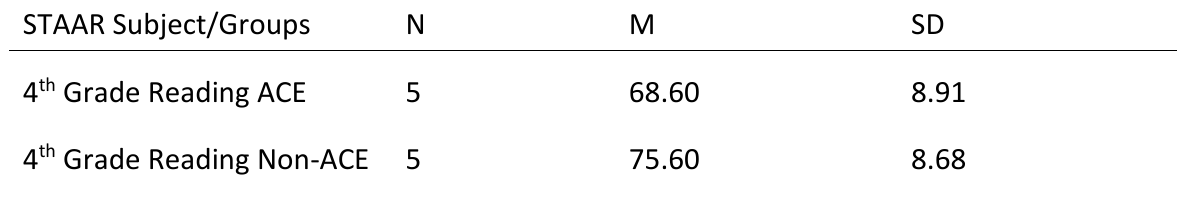
Table 4 : Means and Standard Deviations: Student performance in 4 th Grade STAAR Reading STAAR Subject/Groups N M SD